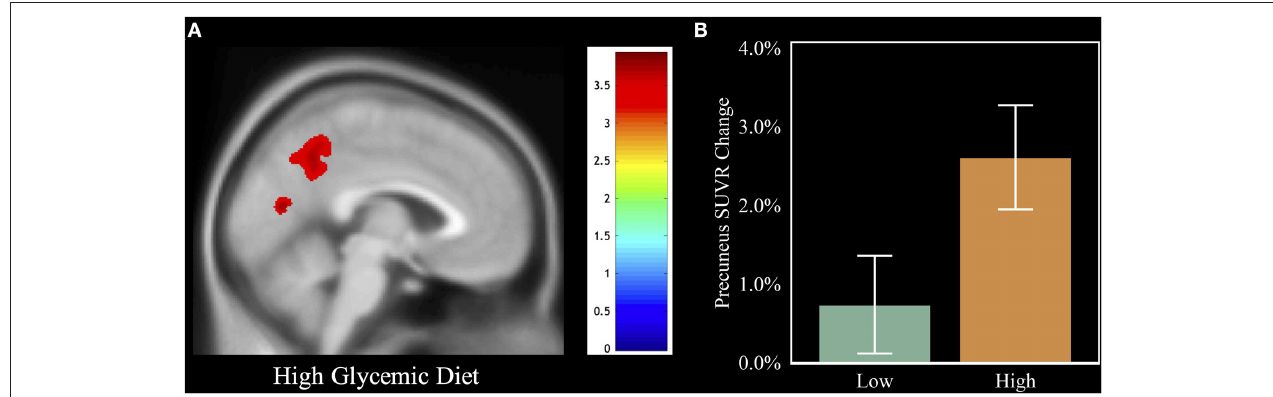
FIGURE 3 | Visual of the relation between HGDiet intake and 1-year amyloid change. To illustrate the relation between HGDiet pattern scores and change in cerebral amyloid, we performed voxel-based amyloid PET analyses comparing SUVR change with a binary variable of adherence to the HGDiet pattern (high vs. low using a median split). (A) demonstrates that individuals in the high HGDiet group accumulated more amyloid over 1 year in the precuneus and cuneus compared to the low HGDiet group ( p < 0.05 FWE corrected for multiple comparisons). (B) illustrates the contrast of mean precuneal amyloid accumulation between the high HGDiet and low HGDiet groups. Analyses were adjusted for age, sex, APOE, and treatment group.